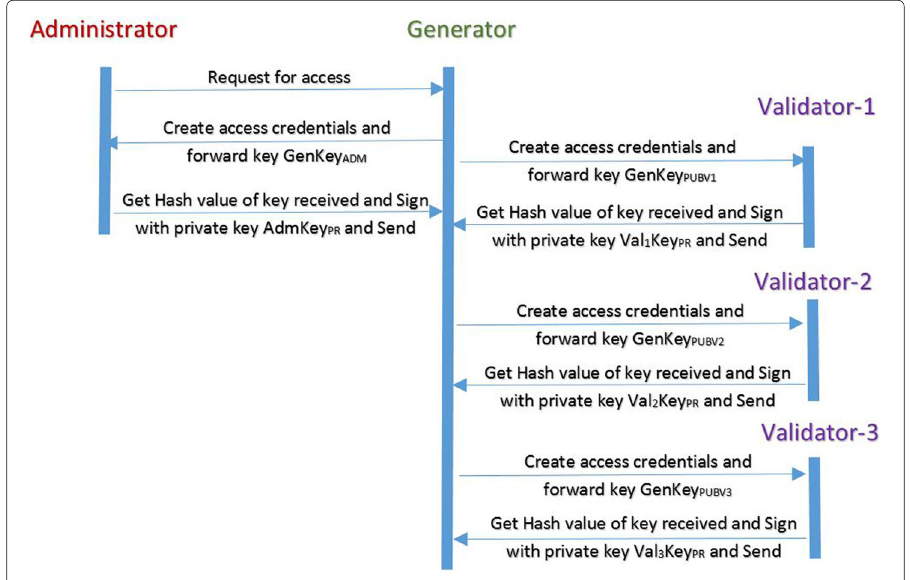
Fig. 6 Vault access sequence of events by split